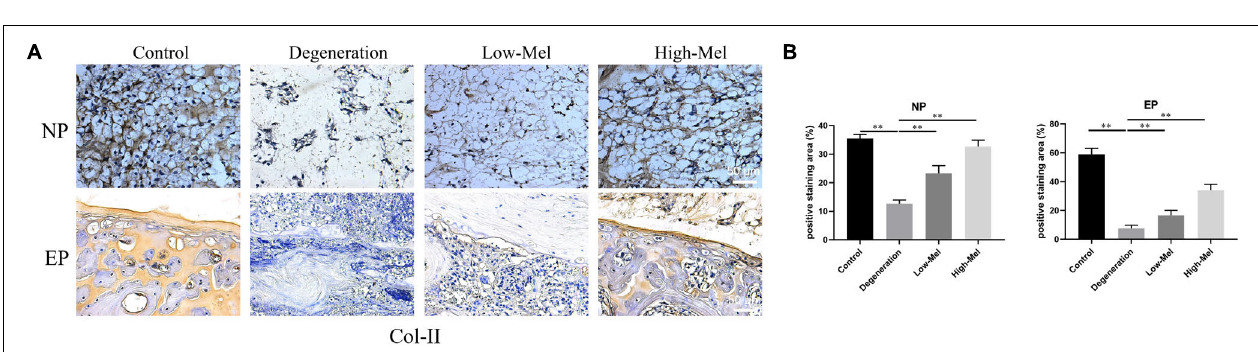
FIGURE 2 | Melatonin (Mel) treatment reduced the degradation of extracellular matrix (ECM). (A) Immunohistochemical staining of type II collagen (Col-II) in both nucleus pulposus (NP) tissues and endplate (EP) tissues of rats on the 7th day after puncture injury. (B) Semi-quantitative analysis of Col-II on the 7th day after puncture injury ( n = 5, ∗ P < 0.05, ∗∗ P <